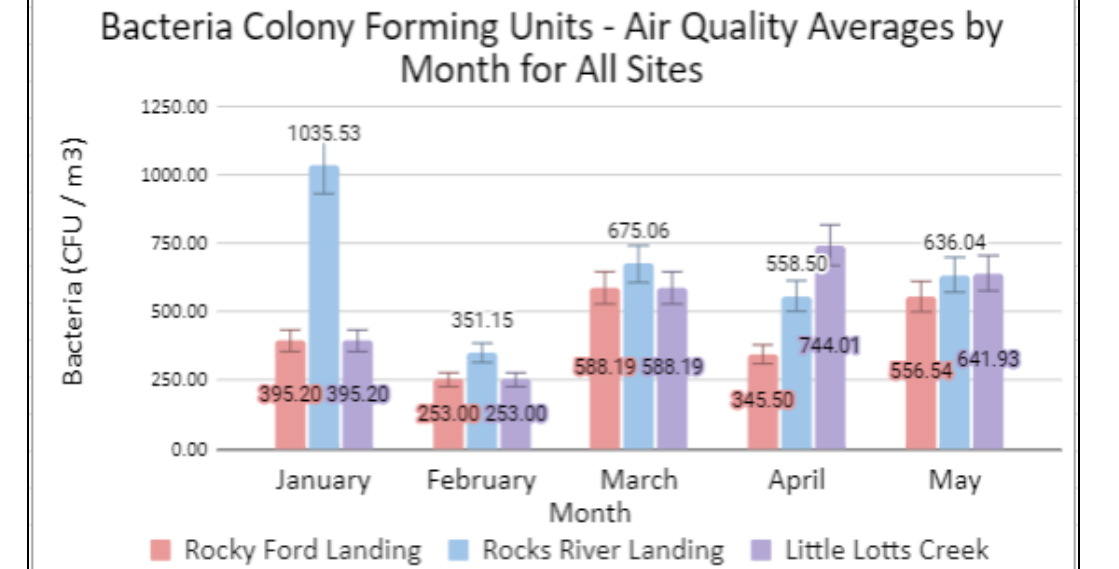
Figure 6. Air Quality — Total Culturable Bacterial Concentrations. Table 1. Total Overall Air Quality Averages from All Sites. Total Air Quality Averages and Standard Deviations from January–May